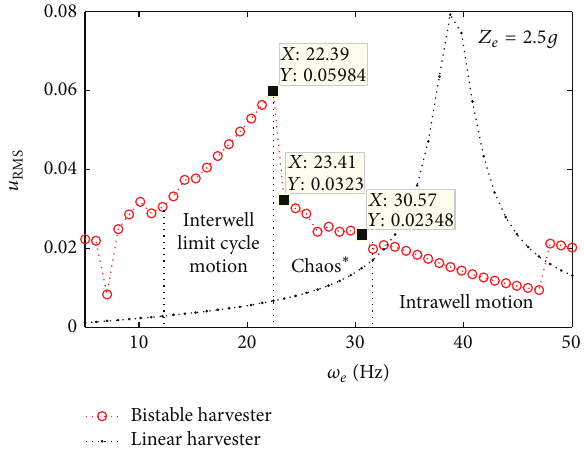
Figure 5: Numerically obtained effective voltage outputs during frequency sweep of the bistable harvester versus the linear harvester for 𝑍 𝑒 = 2.5𝑔